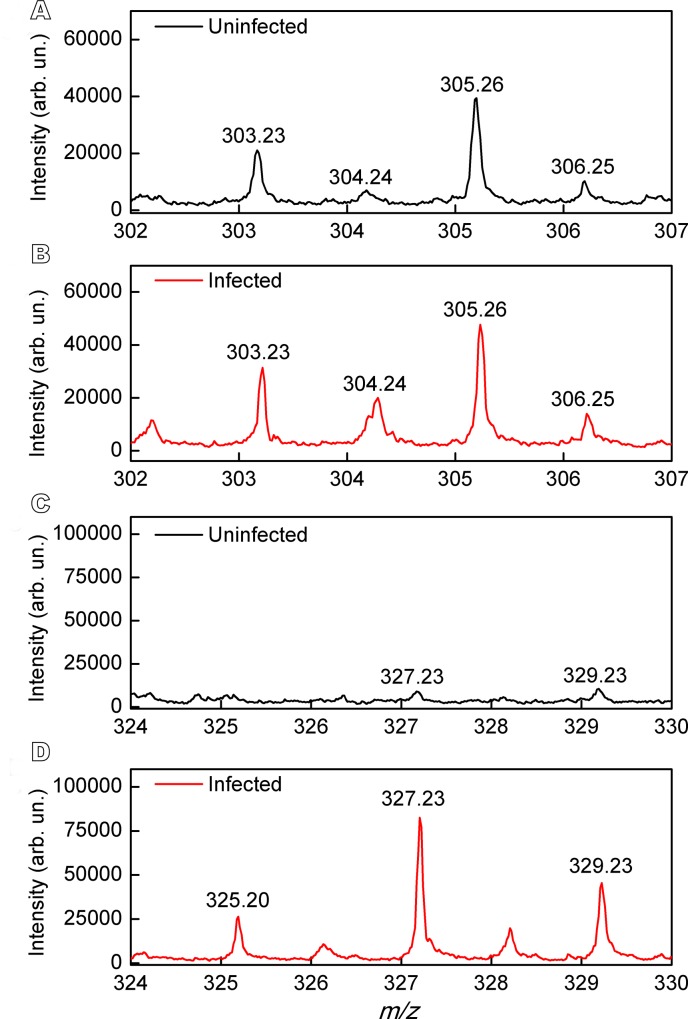
MALDI-TOF mass spectra of liver tissues reveal high concentration of arachidonic acid (AA) in naturally S. mansoni-infected N. squamipes.(A, B) Mass spectra, from 301 to 307 m/z range showing peaks attributed to sodium adduct of the linoleic acid [M + Na]+ (m/z 303.03), AA (m/z 304.24) and sodium adduct of the oleic acid [M + Na]+ (m/z 305.26). (C, D) Mass spectra from 324 to 330 m/z range. The peak observed at 327 m/z represents sodium adduct of the AA [M + Na]+. Liver sections from uninfected and naturally S. mansoni-infected N. squamipes (n = 3 sections from each group) were cut on a cryostat (50 μm thickness) and analyzed without any labeling.